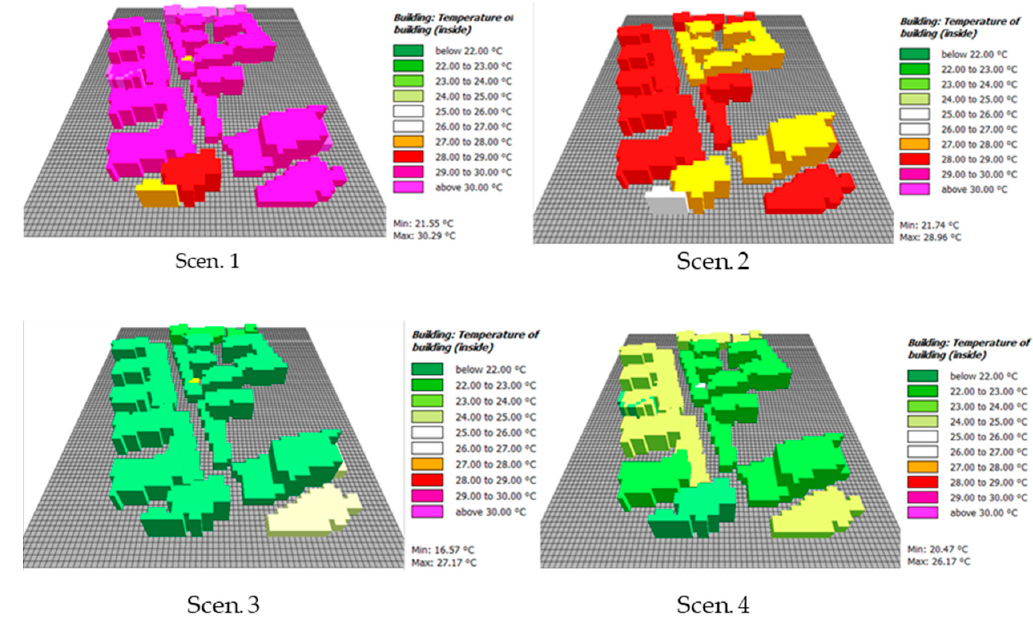
Figure 8. Air temperature inside of the four scenarios at 10 p.m.